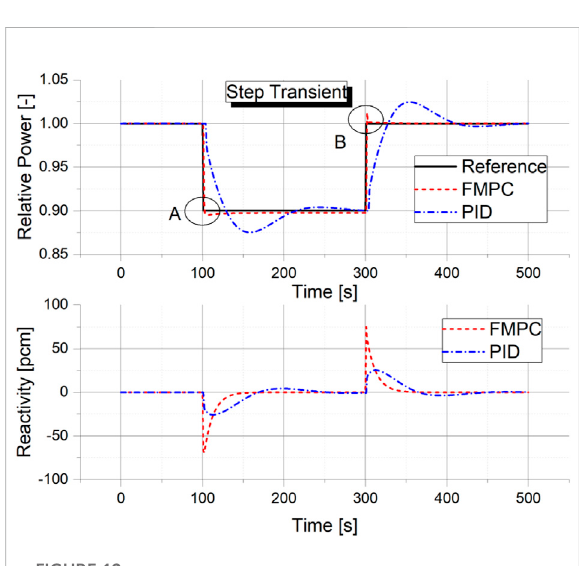
Simulation results for the working condition: step transient.